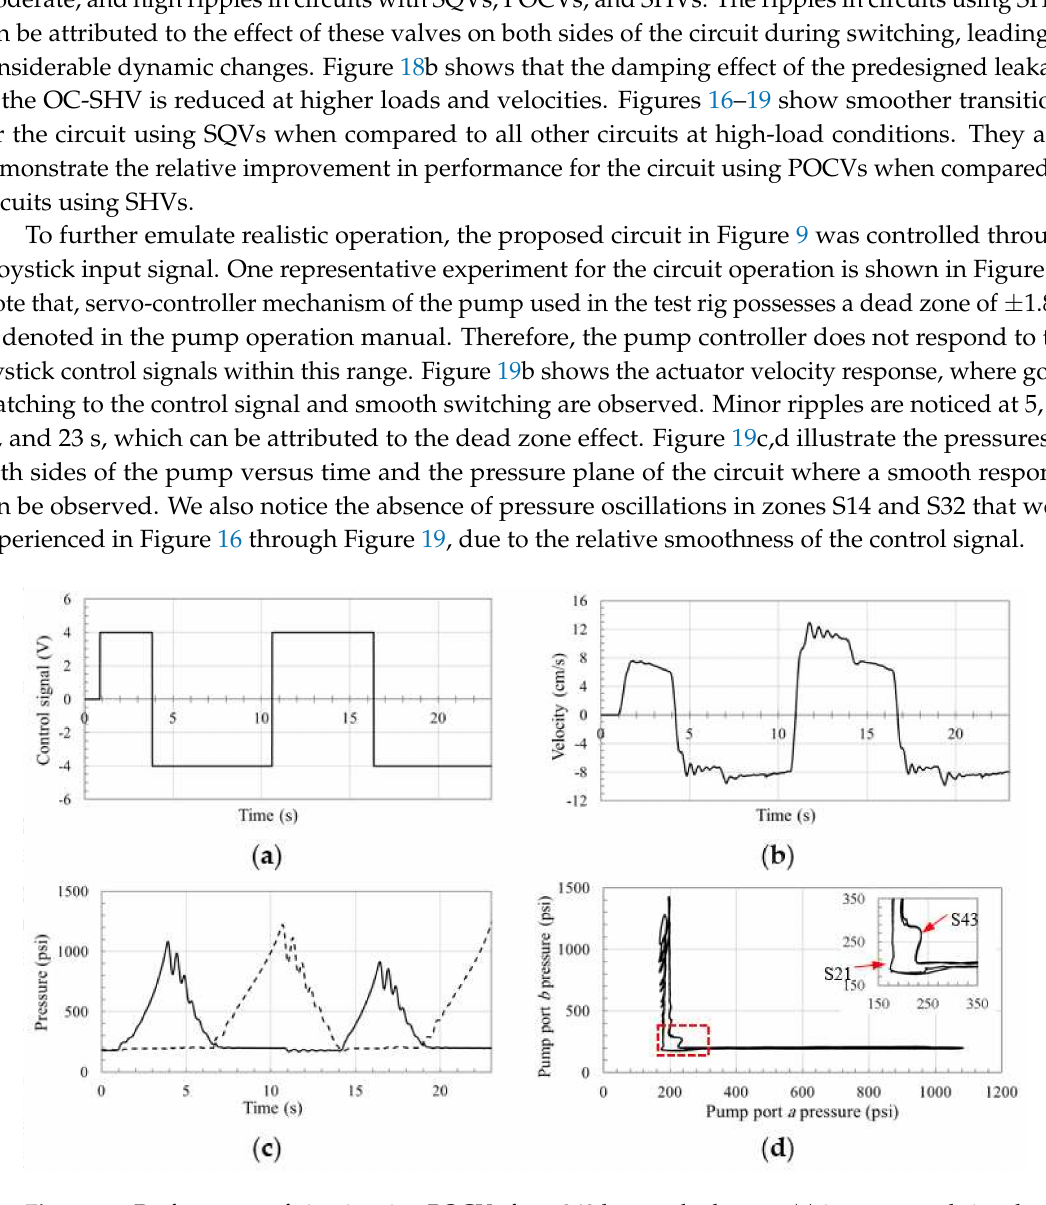
Figure 16. Performance of circuit using POCVs for a 368 kg attached mass: ( a ) input control signal; ( b ) actuator velocity; ( c ) pressures at the pump ports a (solid line) and b (dotted line); ( d ) pump pressure